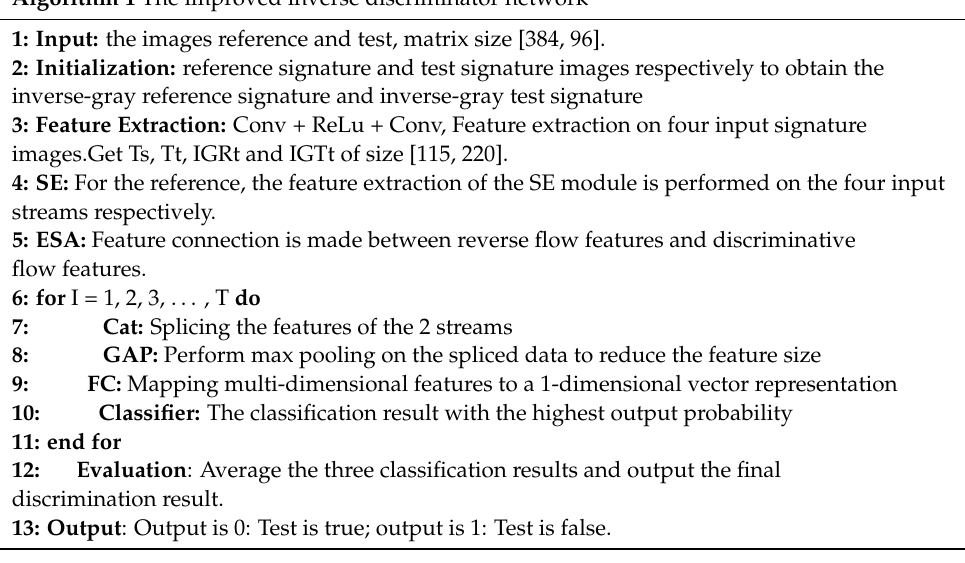
Algorithm 1 The improved inverse discriminator